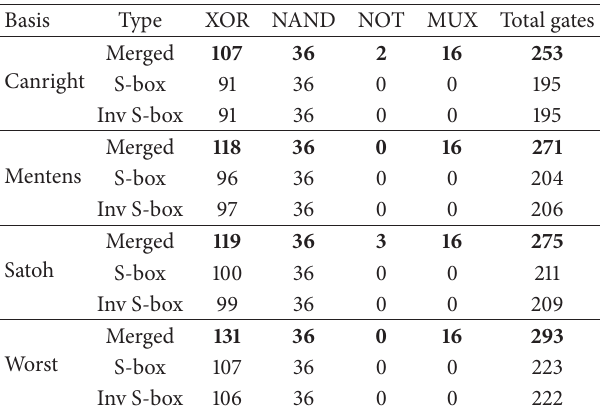
Table 2: The comparison of S-boxes (table from